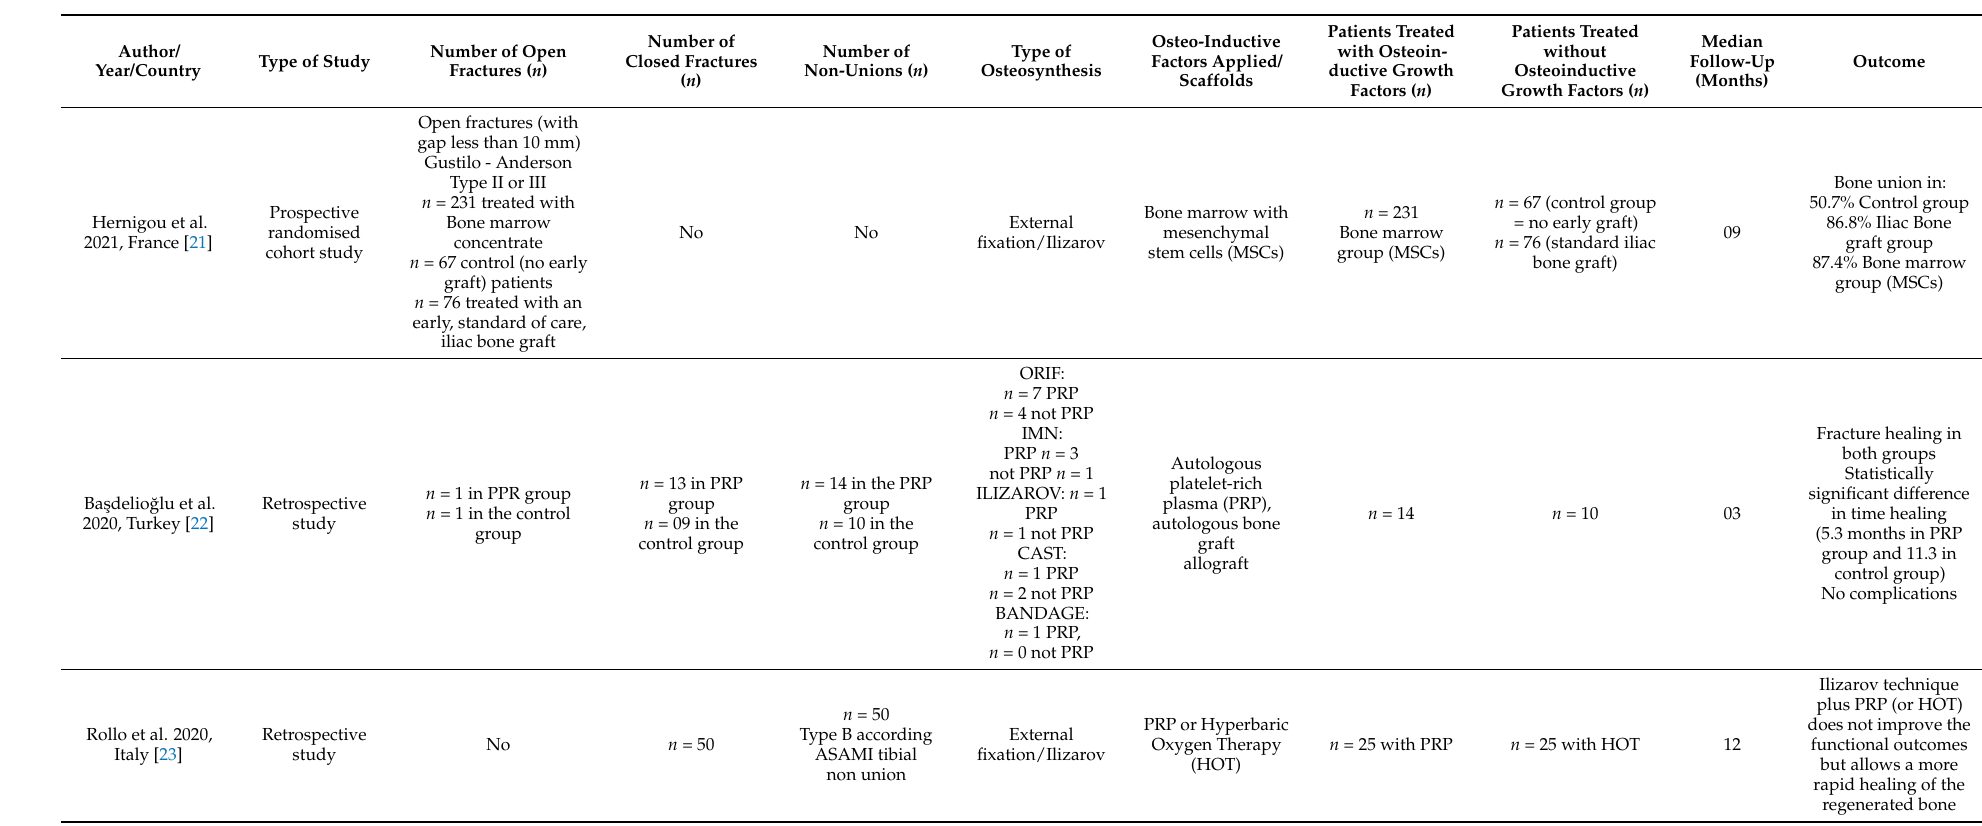
Table 1. Clinical characteristics of the studies included for meta-analysis with osteoinductive factors for long bone fracture healing (N/A: applicable, Pts: patients, rh: recombinant human, MSCs: Mesenchymal cells, PRP: Platelet Rich Factor, BMP: Bone Morphogenetic